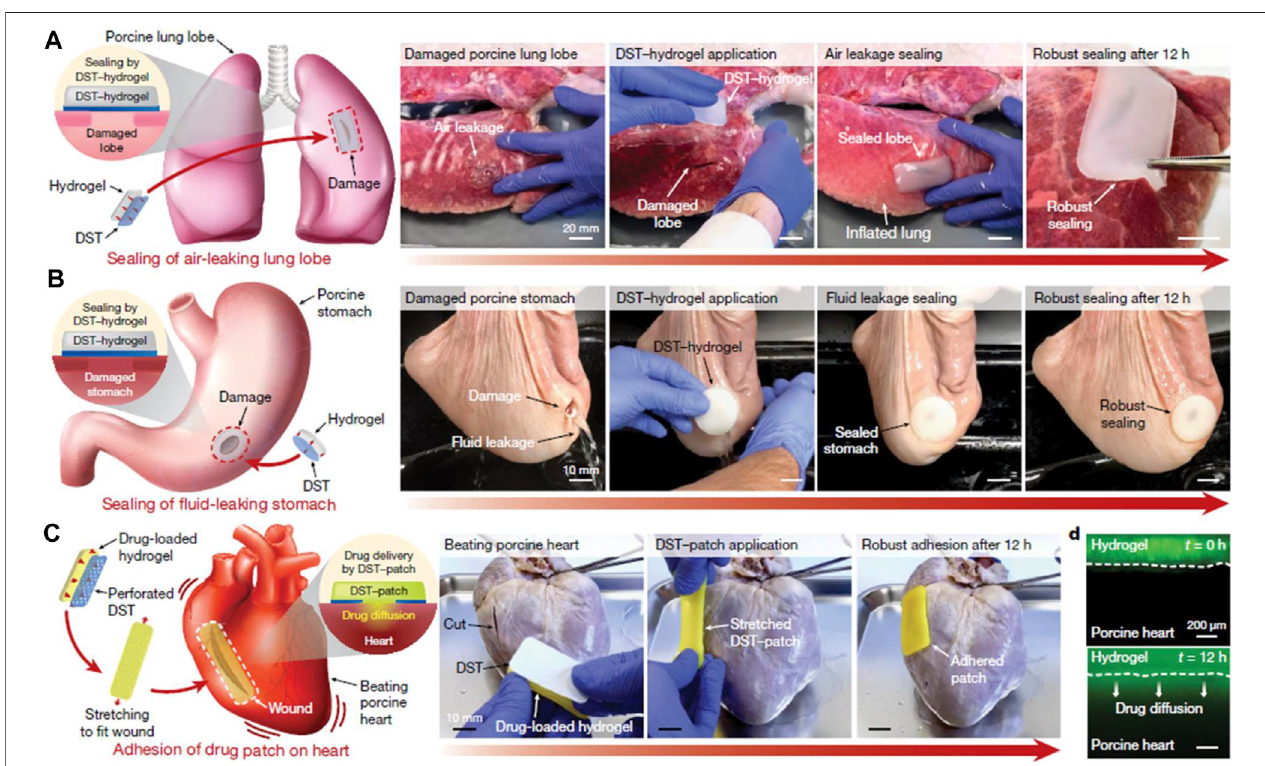
FIGURE7| PotentialapplicationsoftheDST. (A) Sealingofanair-leakinglacerated exvivo porcinelunglobebyahydrogelpatchadheredwiththeDST. (B) Sealing of a fl uid-leaking ex vivo porcine stomach by a hydrogel patch adhered with the DST. (C) DST-mediated adhesion of a drug-loaded patch on a beating ex vivo porcine heart with a cut. (D) Diffusion of a mock drug ( fl uorescein) from a DST-adhered drug patch into the ex vivo porcine heart tissue over time. Reproduced from (Yuk et al., 2019) with permission from Copyright 2019